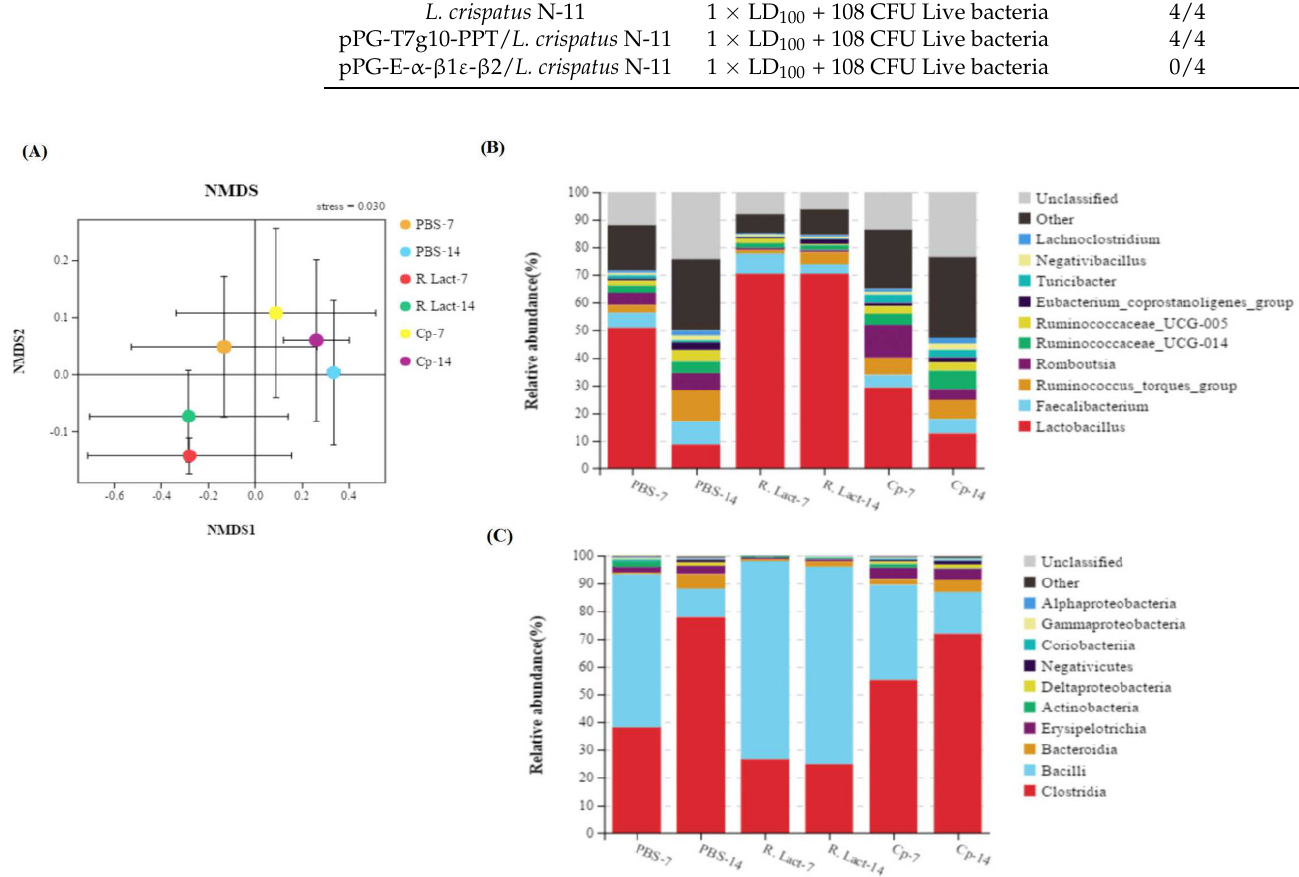
Figure 10. Microbial structure community of different groups. ( A ) Non-metric multidimensional scaling analysis of different groups. ( B ) Comparison of species composition analysis at the genus level. ( C ) Comparison of species composition analysis at the class level.